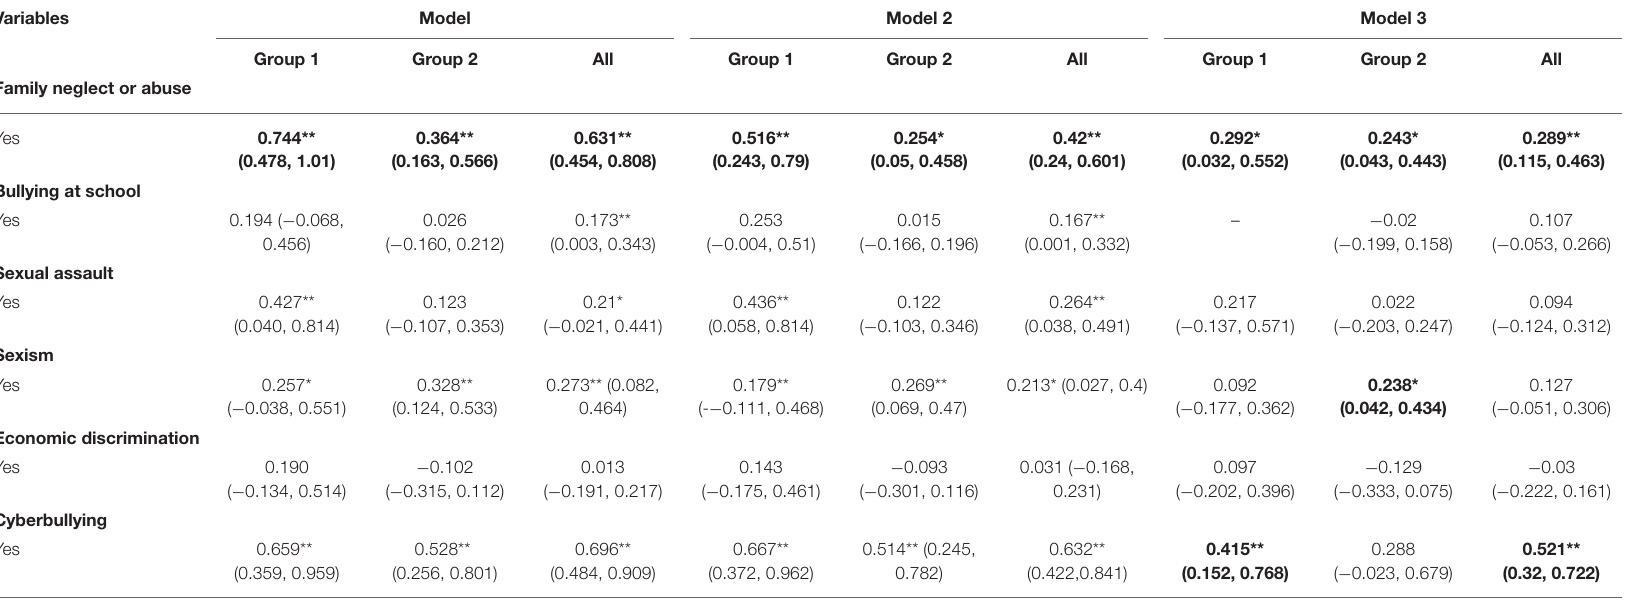
TABLE 3 | Association (beta coefficient) between SHS and suicide risk score by multiple linear regression among different grade adolescents. Variables